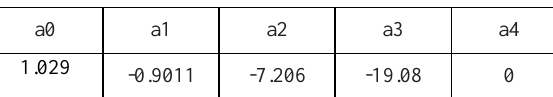
Figure 4. The correlation between the in-situ data and the